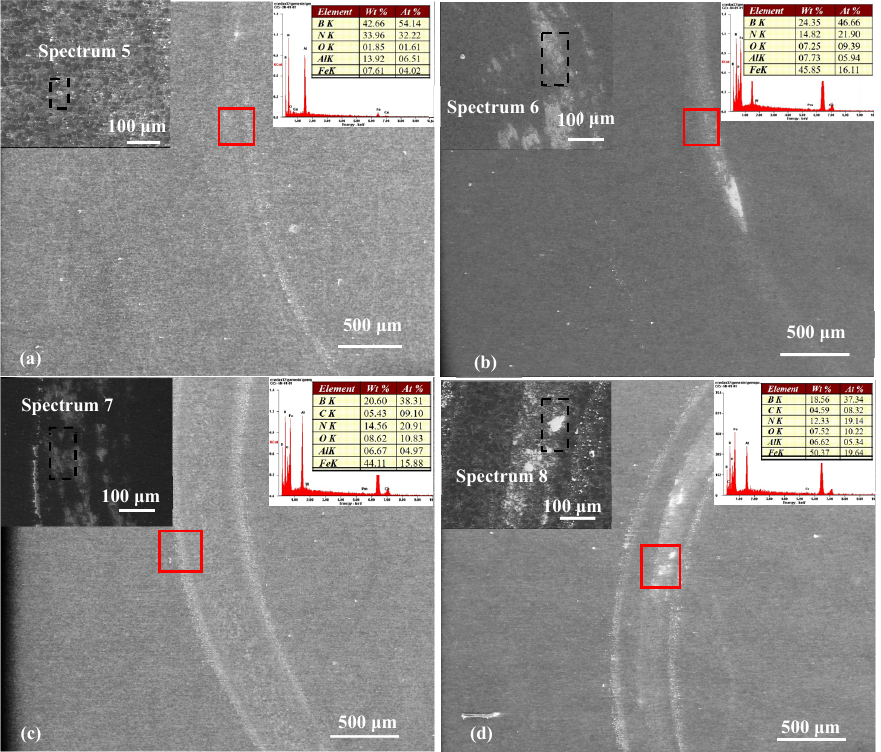
Figure 4. SEM wear morphologies of PcBN under different loads: ( a ) 2 N; ( b ) 5 N; ( c ) 10 N; ( d ) 15 N. The inserts on the left of ( a – d ) are the high magnification of the corresponding red box positions. The EDS result on the right of ( a – d ) represent the elements on the black dashed box.